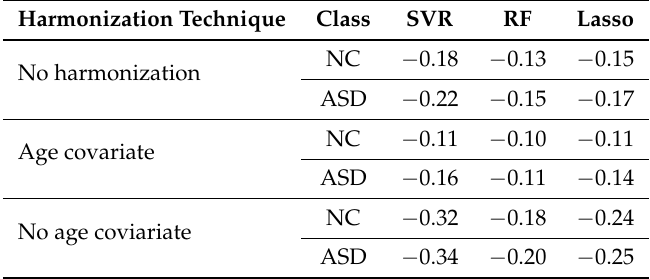
Table 5. Signed difference between the AUC ˆ y of the ideal model fit and each of the nine best-fitting models for NC and ASD